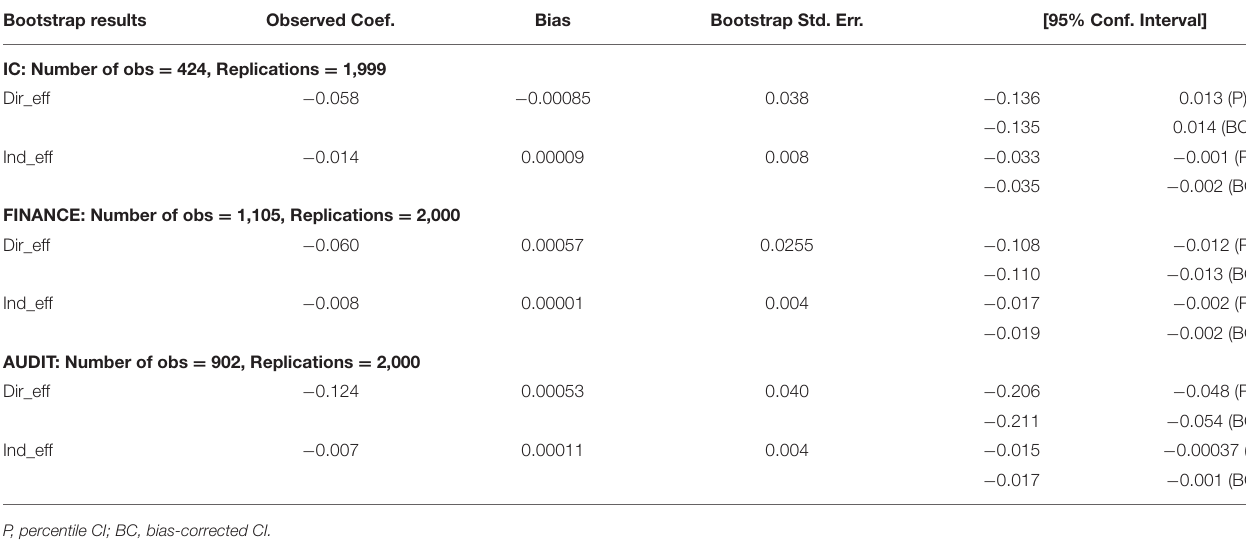
TABLE 10 | Bootstrapping test for mediation effect.